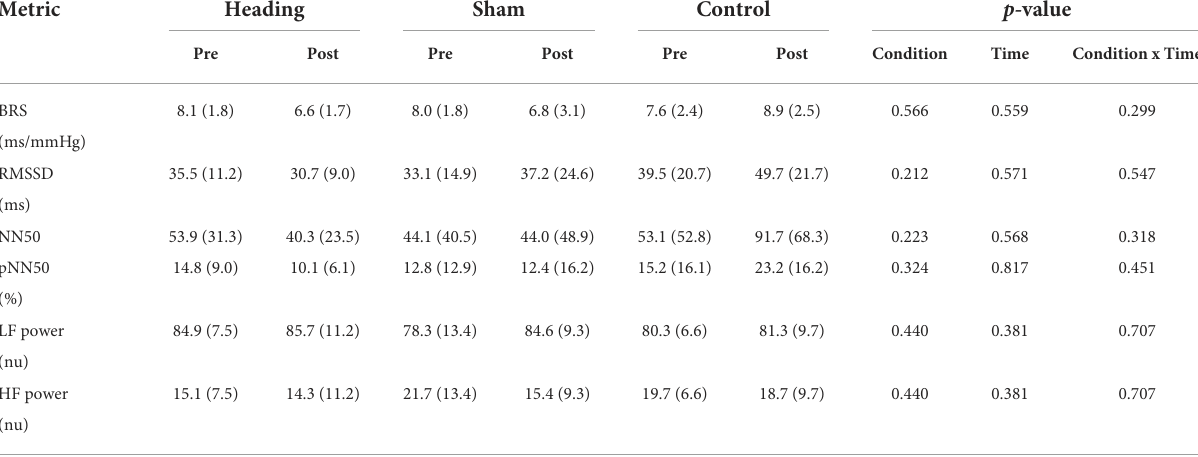
TABLE 2 Baroreceptor sensitivity and heartrate variability before and after heading, sham, and control exposures.